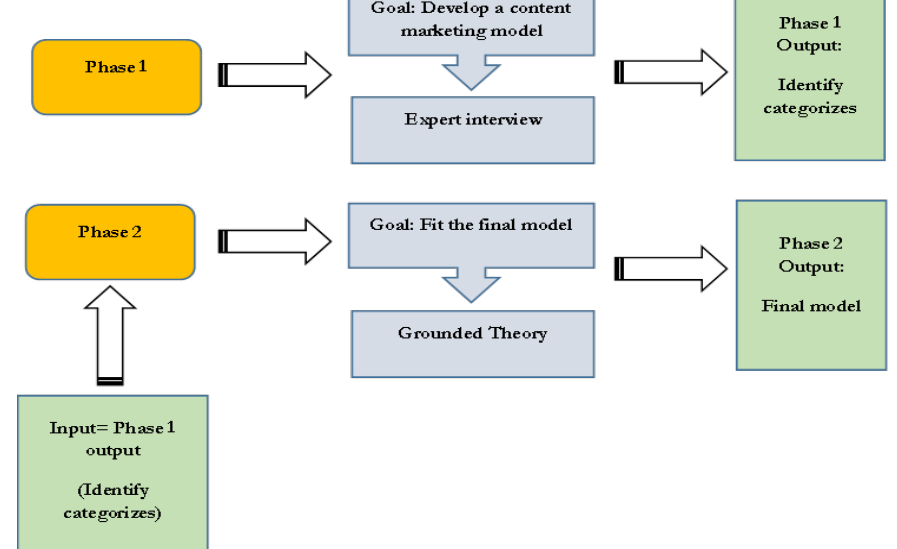
Fig. 2. Research methodology